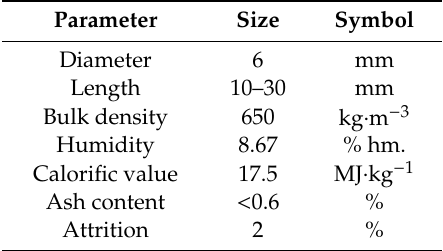
Table 1. Physical parameters of the pellet.